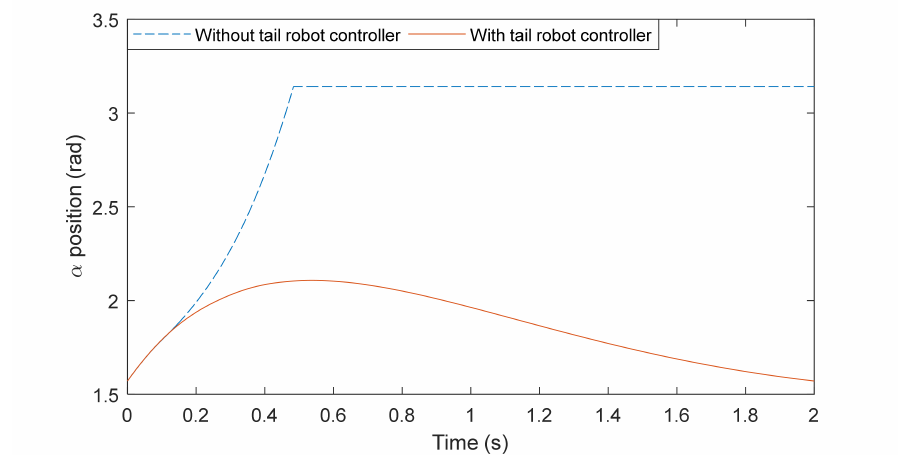
Figure 10. Plot of angle α . Biped robot’s response to external